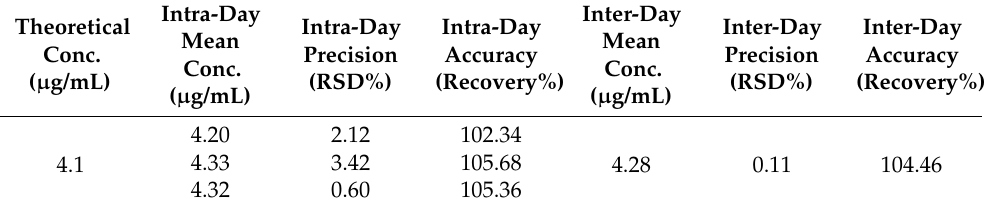
Table 3. Method validation for β -carotene: evaluation of precision (RSD %) and accuracy (Recovery %) in the short- and long-term period (intra-day and inter-day precision and accuracy values). Theoretical